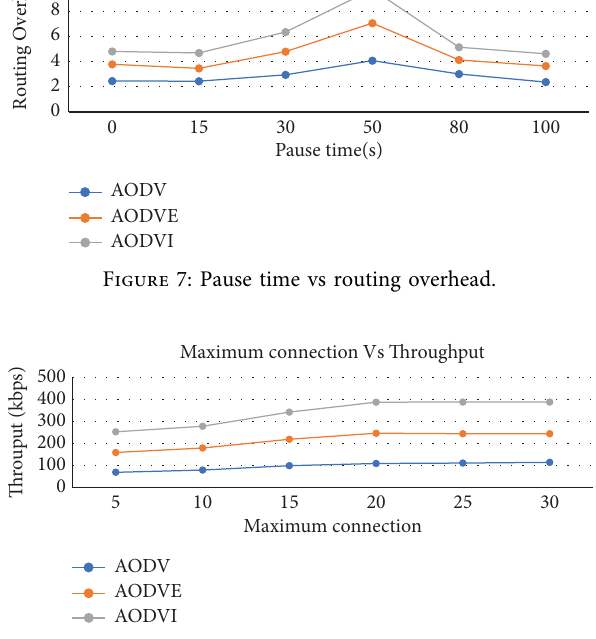
Figure 8: Maximum connection vs